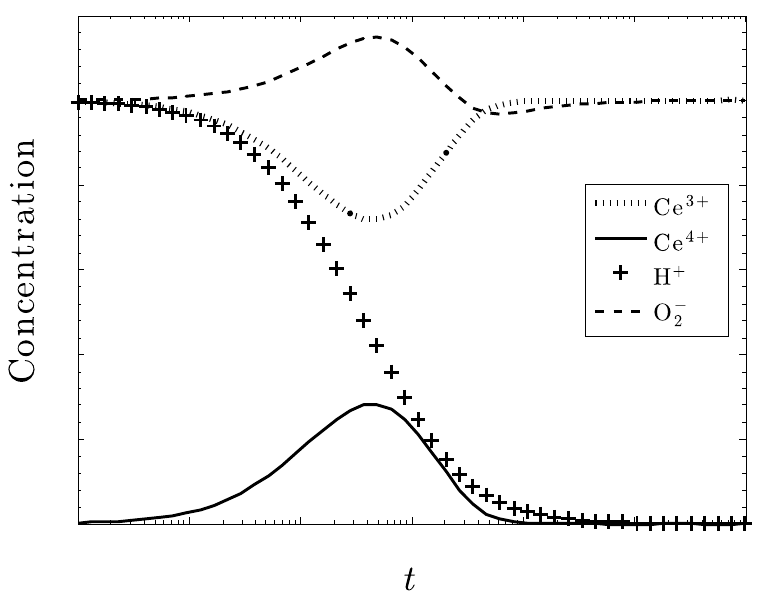
Figure 2. Only Ce 3+ ion is present in the Ce 2 O 3 crystal. All other species are equivalent as are their respective rate constants. There is a slight increase in the superoxide concentration that then returns to its original level.